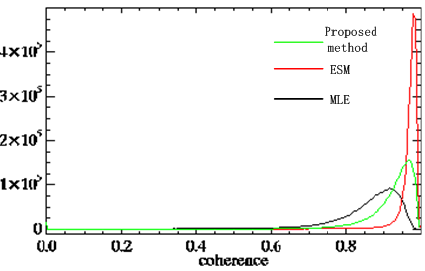
Figure.8.Coherence histograms of three methods DSMs derived from three methods can be obtained shown in figure.9. As shown in figure.10. , histograms in green, red, white colors show the height distribution of three